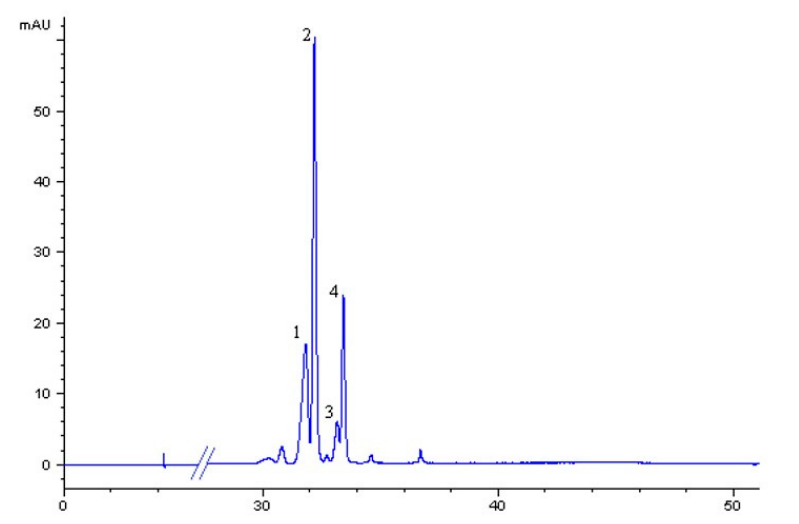
Figure 5. A typical HPLC-DAD chromatogram ( λ : 520 nm) of the extracts analyzed. The operating conditions are reported in the HPLC section. Peak assignment: 1: delphinidin-3-O-glucoside, 2: cyanidin-3-O-glucoside; 3: cyanidin-3-O-rutinoside; 4: malvidin-3-O-glucoside.